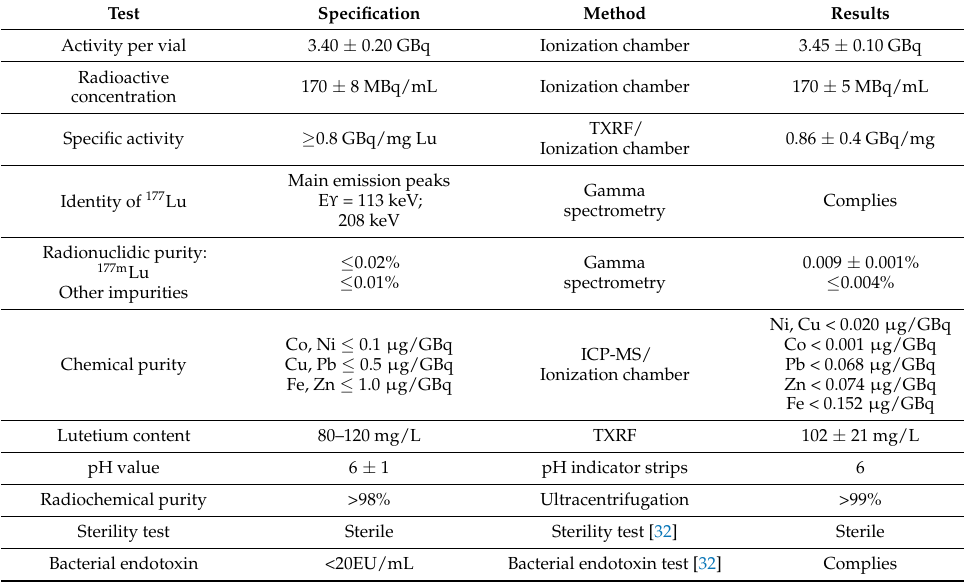
Table 1. Quality control analytical results of [ 177 Lu]Lu−iFAP/iPSMA nanoparticles produced under GMP conditions (results of three batches).